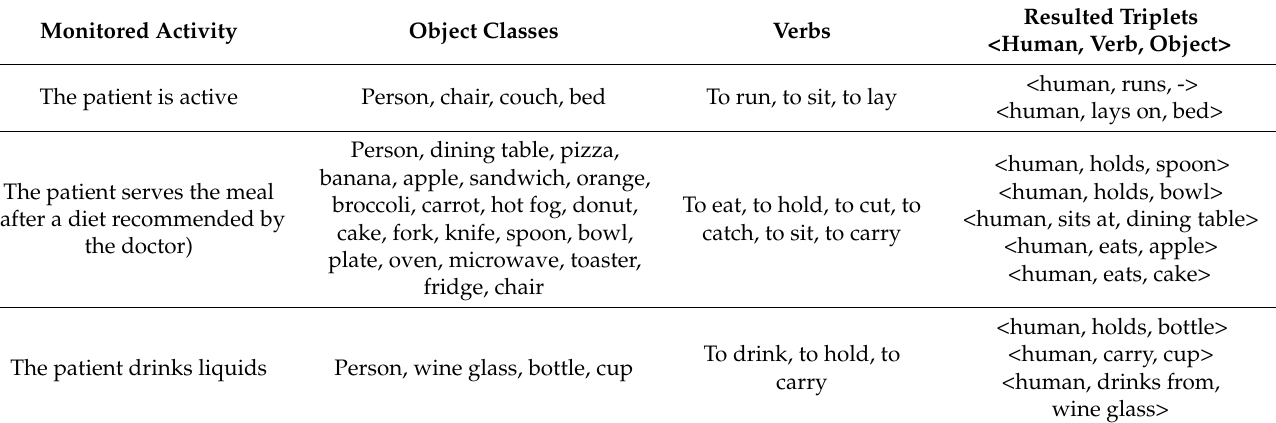
Table 3. Monitoring scenarios for